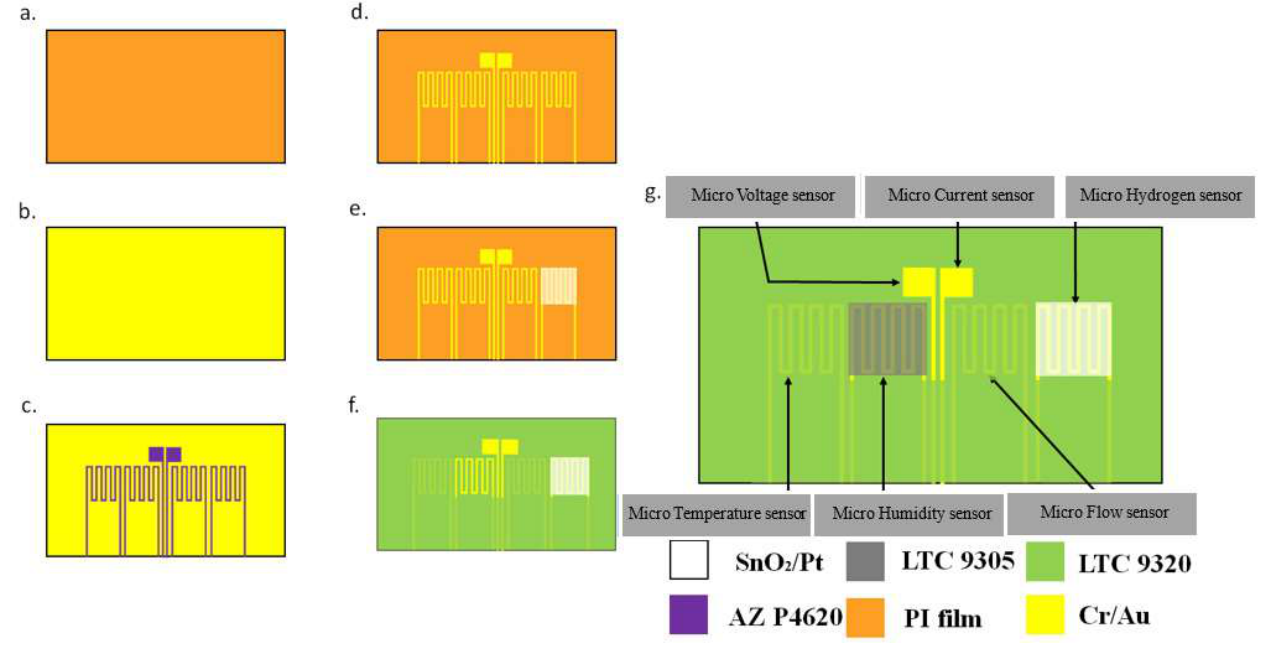
Figure 2. Process flowchart of flexible six-in-one microsensor.